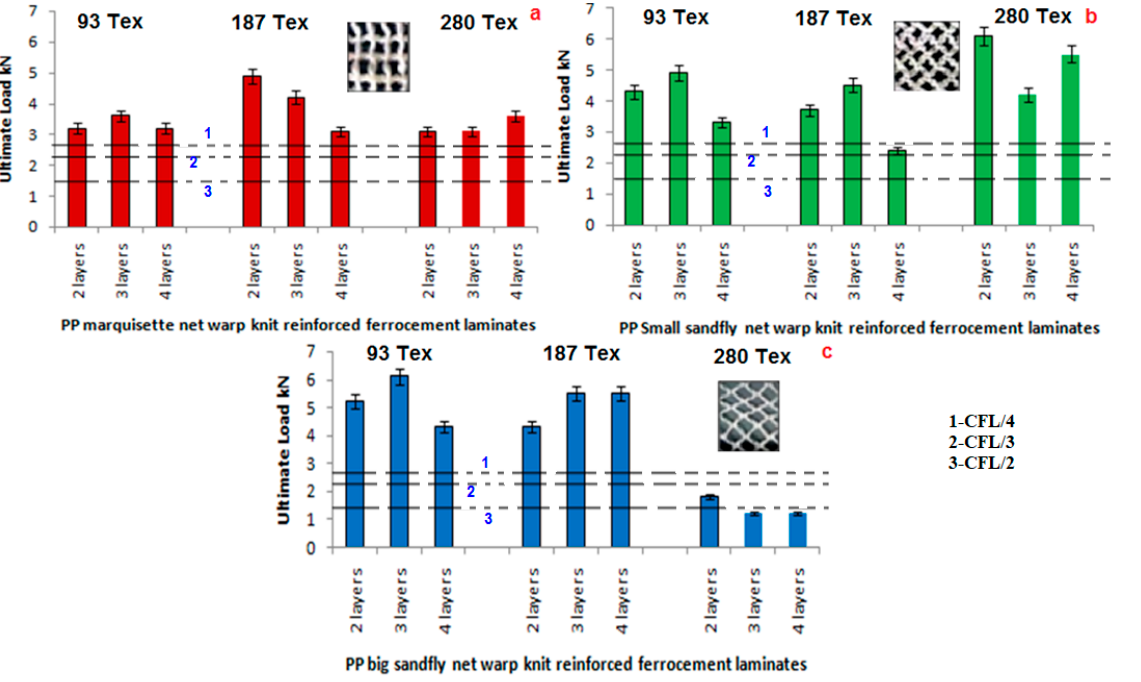
Figure 8. Ultimate load analysis of ( a ) marquisette, ( b ) small sandfly, and ( c ) big sandfly net polypropylene warp knitted reinforced ferrocement composites.